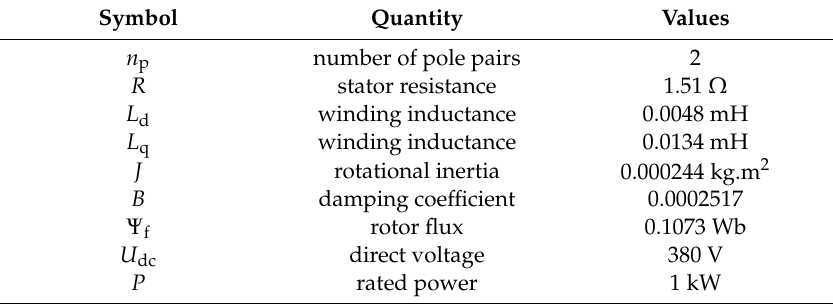
Table 1. Parameters of the PMSM.